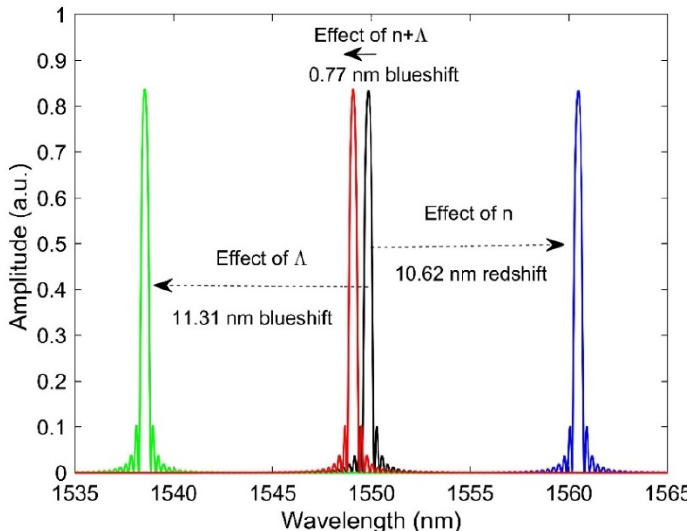
Figure 6. Spectra of FBG in different conditions: before irradiation (black curve), radiation-induced RI effect (blue curve), radiation-induced grating period effect (green curve), and radiation-induced combined effect of RI and grating period (red curve) on the Bragg wavelength.